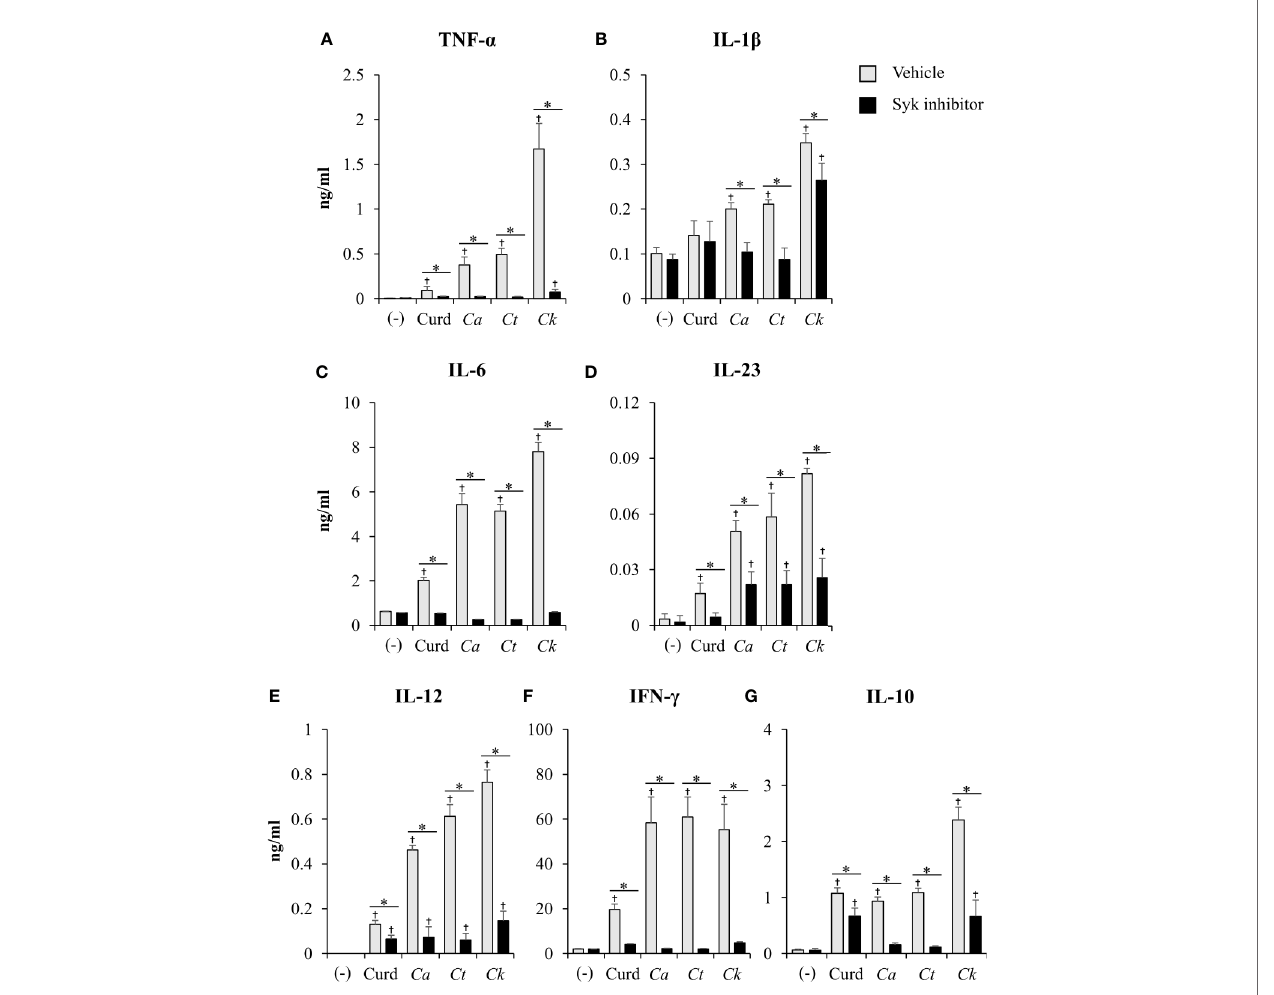
FIGURE 12 | Effects of Syk inhibition on dendriticcell(DC) cytokine production.Bone-marrow derived DCs (BMDCs) were pre-treated with 1 µM of Syk inhibitor for 30 min, andthen the cellswere stimulatedwith 25 µg/ml of curdlan and b -glucans isolated from C. albicans , C. tropicalis , and C. krusei for 48 h.Levels of (A) TNF- a , (B) IL-1 b , (C) IL-6, (D) IL-23, (E) IL-12, (F) IFN- g , and (G) IL-10 were measured inculture supernatants byELISA. n = 5; data are representative of two independent experiments. † p < 0.05 compared with unstimulated BMDCs, * p < 0.05. (-), unstimulatedBMDCs; Curd,curdlan; Ca , C. albicans ; Ct , C. tropicalis ; Ck , C. krusei